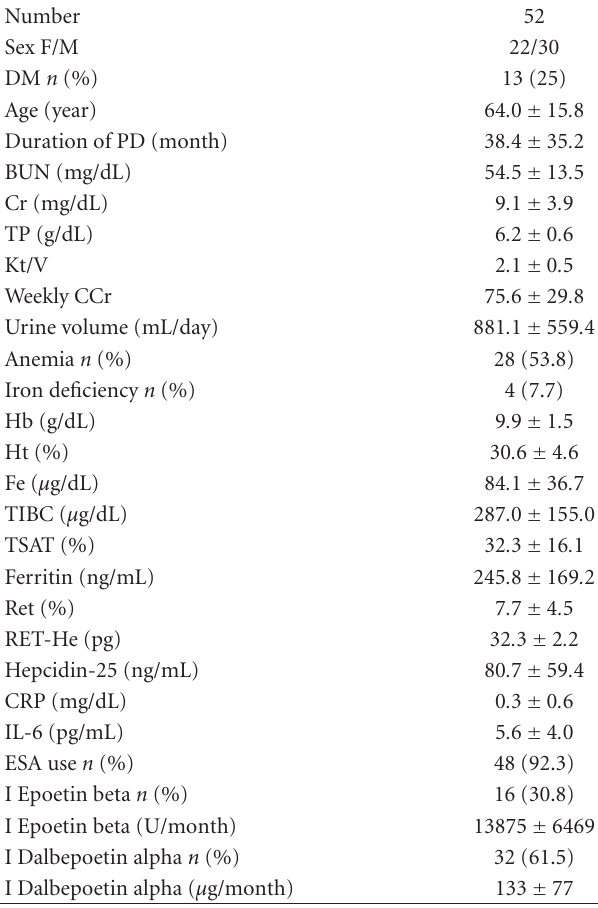
Table 1: The profile of the